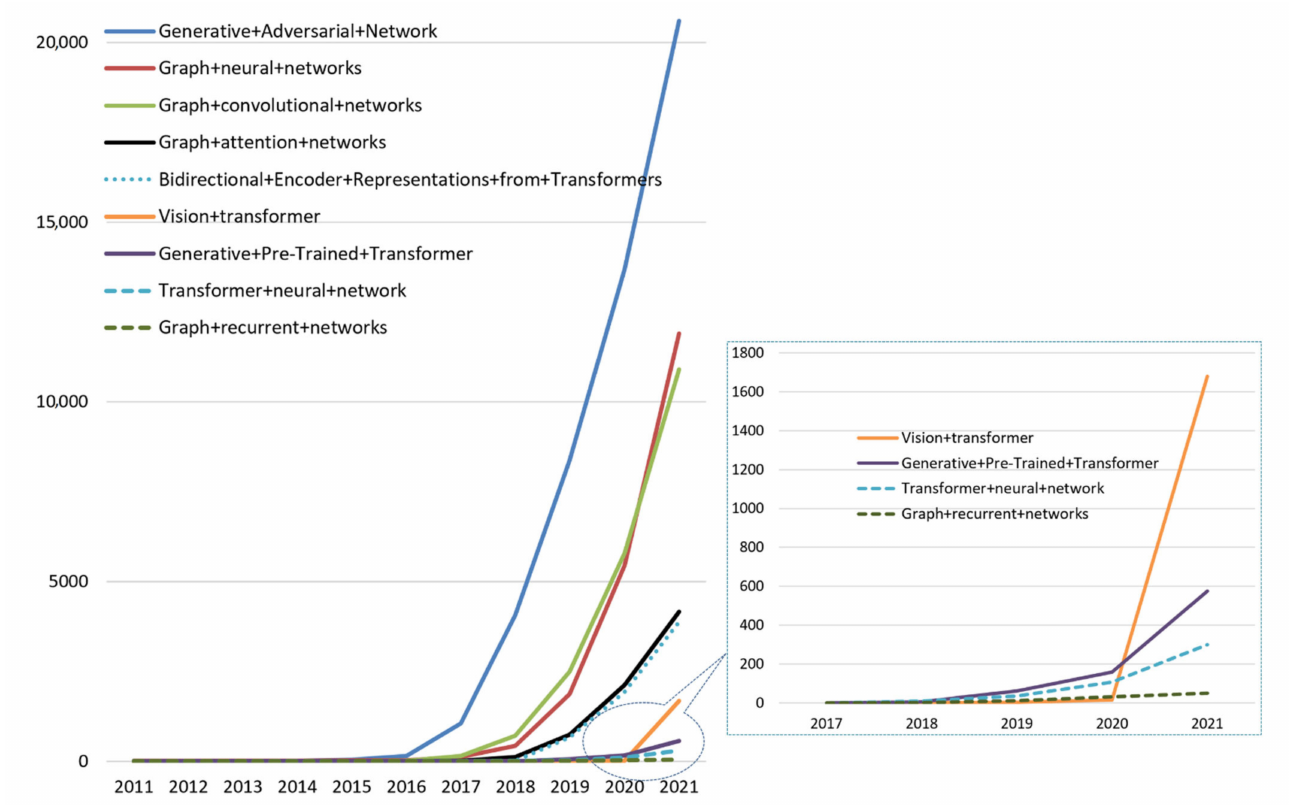
Figure 11. Annual number of publications in deep learning domains related to new neural network architectures. Source: generated by the